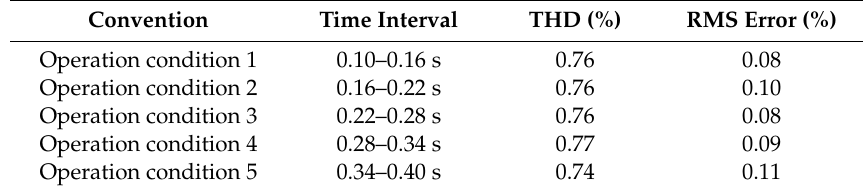
Table 6. Output voltage quality for simulation test 2 (220 V @ 50 Hz).